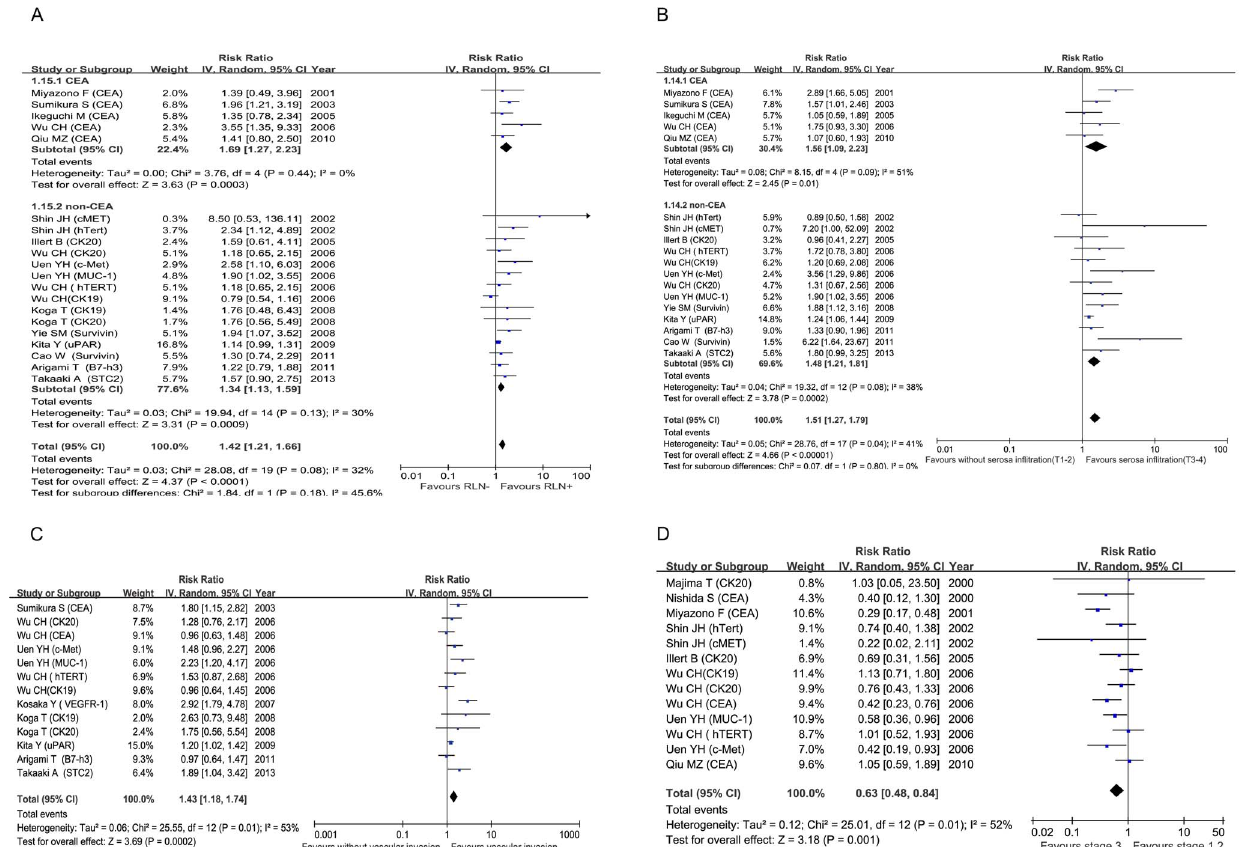
Figure 4. Summary estimates of risk ratio (RR) for RLNs metastasis (A), depth of infiltration (B), vascular invasion (C) and TNM stage (D) (Stage I,II vs Stage III) associated with CTCs positivity. RLNs, regional lymph